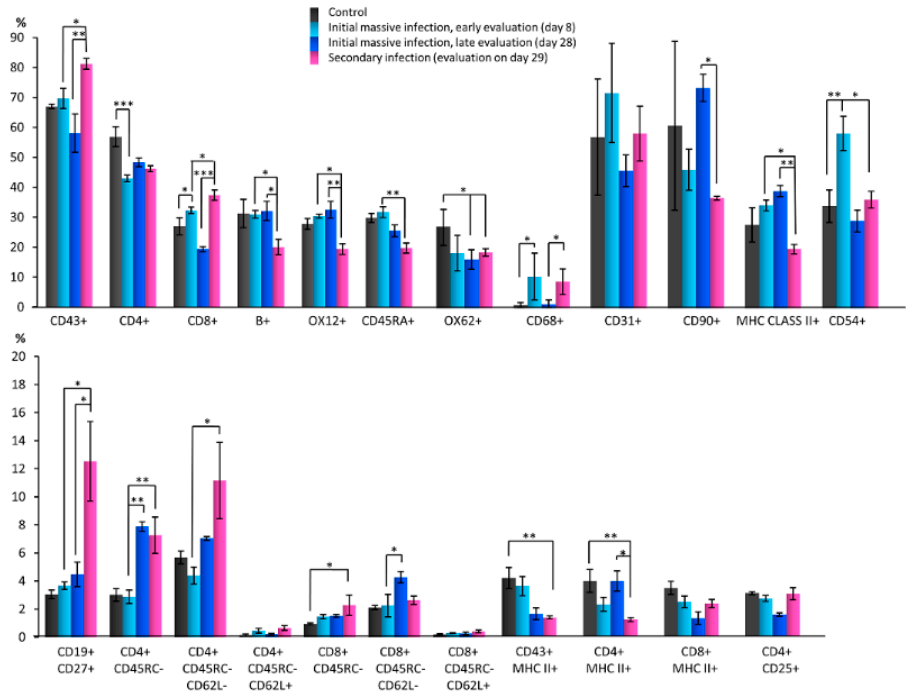
Figure 3. Changes in cell subpopulations of the popliteal lymph nodes in response to S. epidermidis skin infection assessed using a flow cytometry ( n = 32 rats, 64 nodes). CD43+: T lymphocytes; CD4+: